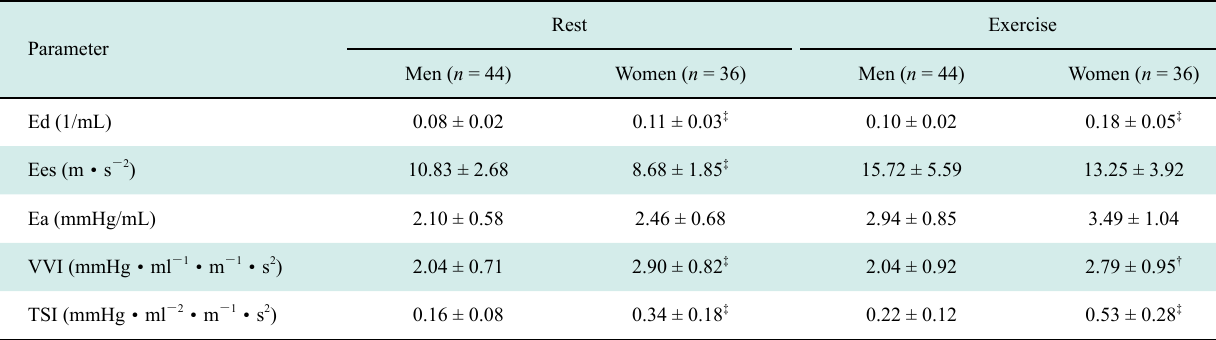
Table 3 Ventricular-arterial stiffness and coupling Parameter